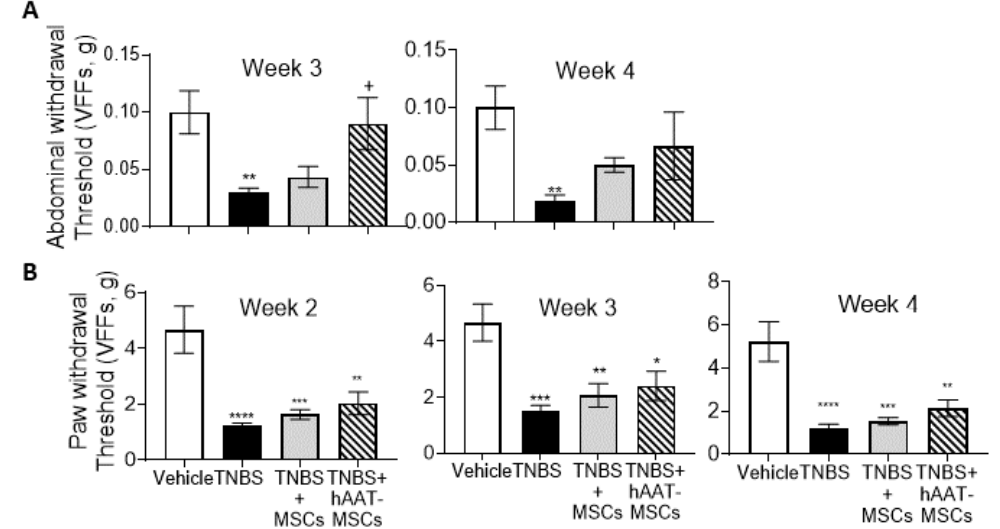
Figure 3. Human alpha-1 antitrypsin overexpressing mesenchymal stromal cells (hAAT-MSC) and MSC infusion reduced mechanical abdominal and paw sensitivities in trinitrobenzene sulfonic acid (TNBS) mice. Mechanical sensitivity was measured with Von Frey filaments (Vehicle = 6, TNBS = 8, TNBS + MSCs = 6, TNBS + hAAT-MSCs = 6 mice per group). TNBS-induced chronic pancreatitis (CP) reduced mechanical ( A ) abdominal and ( B ) paw sensitivities. MSC infusion showed reduced sensitivity to the stimulations, and hAAT-MSCs had a numerically larger although not statistically significant effect on this reduction compared to native MSCs ( p = not significant). The data suggest that MSC infusion may relieve pain in CP. Data presented are mean ± SEM. One-way ANOVA and Tukey’s test were used. + p < 0.5 vs. TNBS, * p < 0.05, ** p < 0.01, *** p < 0.001, **** p < 0.0001 vs.